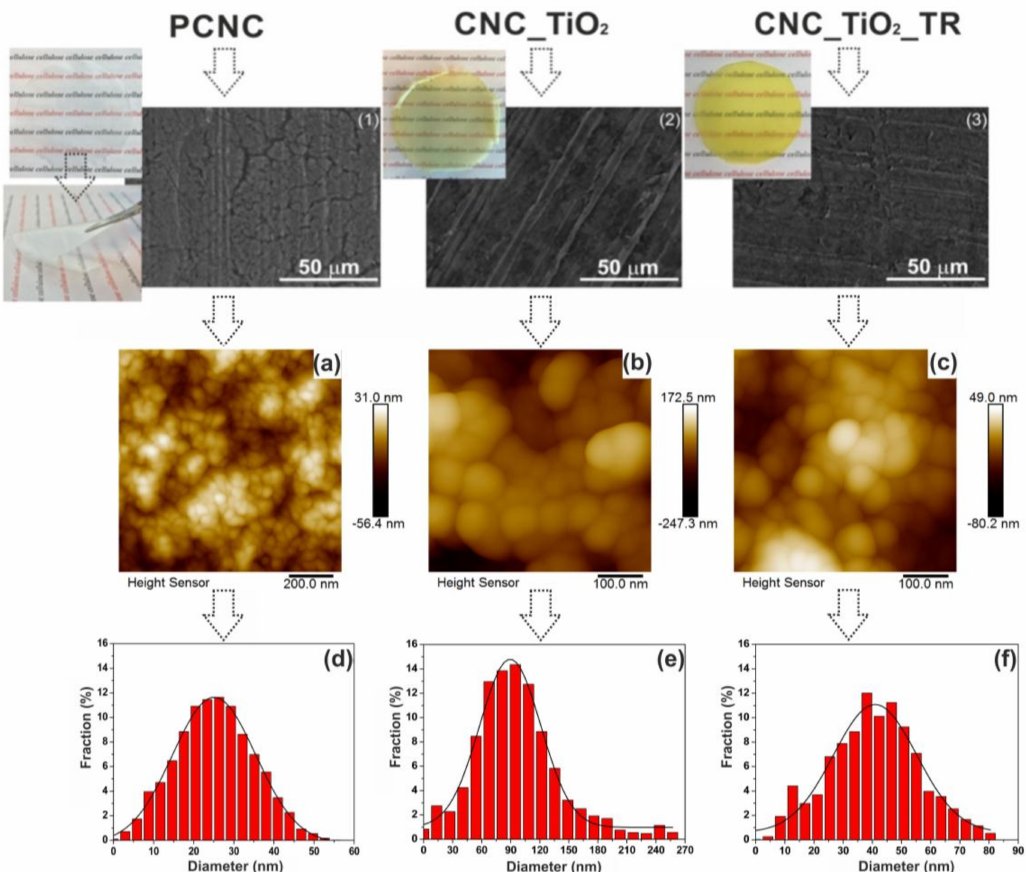
Figure 1. Morphology images obtained by AFM ( a – c ) and SEM ( 1 – 3 ) microscopy together with visual images, particle size distribution (theoretically fitted using Gaussian distribution function) ( d – f ) of the obtained